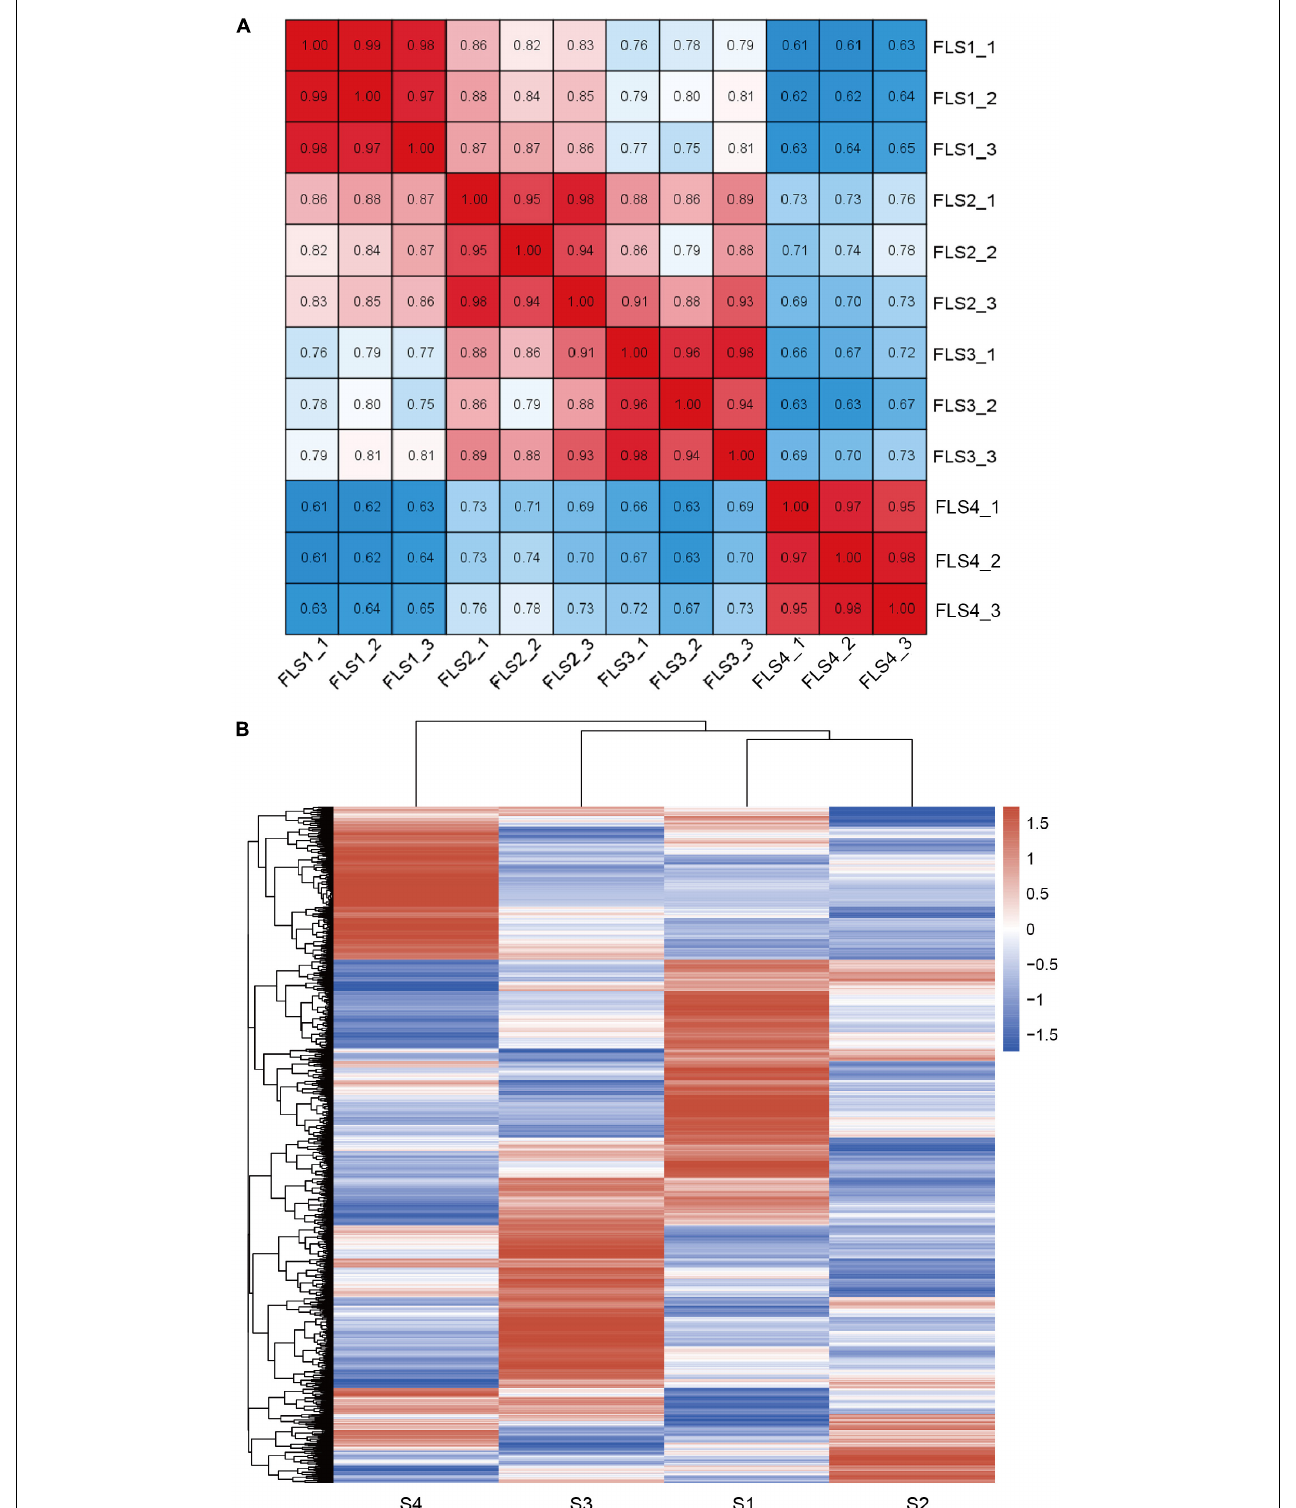
FIGURE 2 | Basic survey of stigma transcriptome during flower development of hickory. (A) Pearson correlation results are based on all transcripts identified from RNA-seq. (B) Heatmaps of all genes by hierarchical cluster analysis (HCA) from RNA-seq.